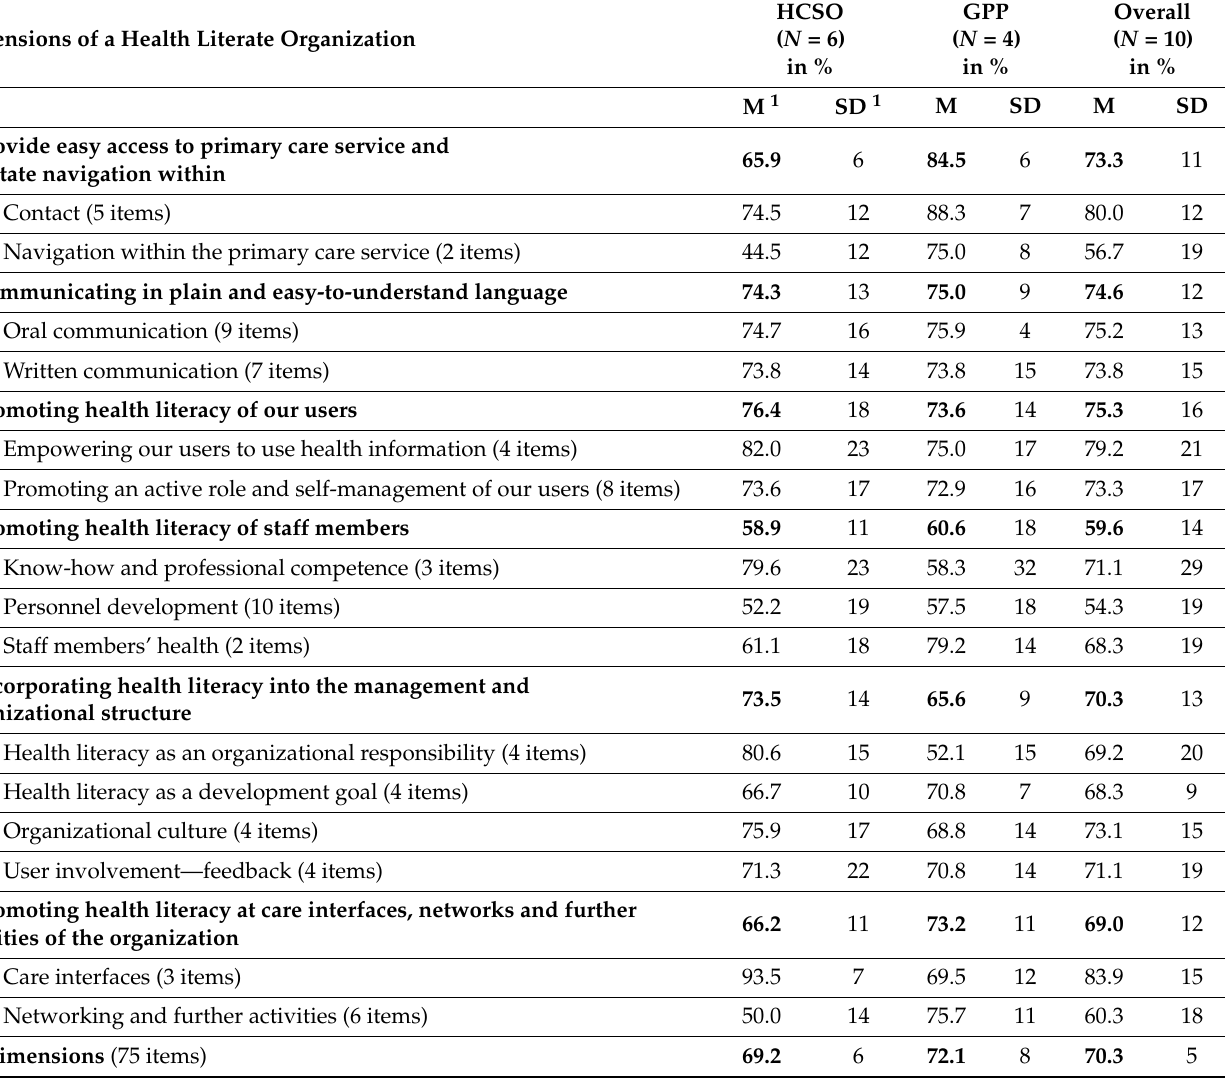
Table 4. Analysis of the OHL Self-AsseT checklist filled out by the self-assessment teams of the home care service organization (HCSO) and the general practitioners’ practices (GPPs). The values range between 0%, indicating no fulfillment of the corresponding criteria, and 100%, indicating that the criteria were completely fulfilled by the organization, according to the self-assessment